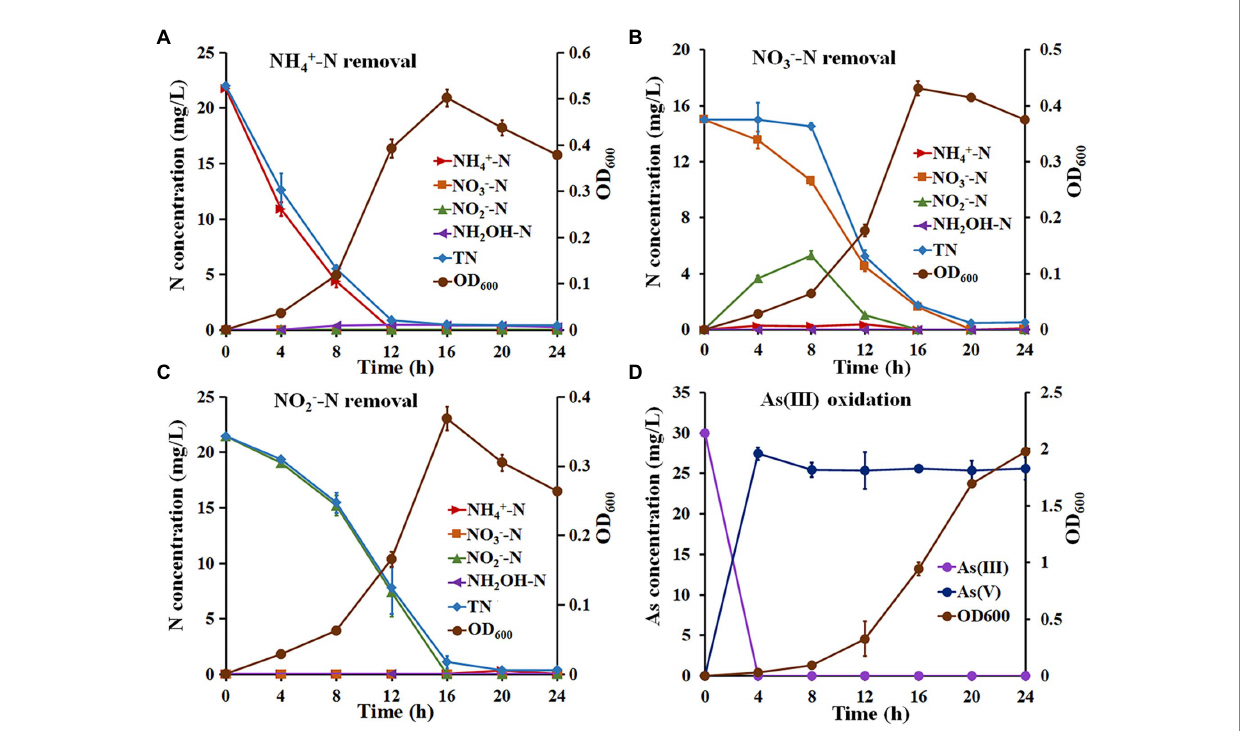
FIGURE 1 The growth, nitrogen removal, and As(III) oxidation characteristics of strain H7. The growth and nitrogen removal curves of strain H7 using NH 4+ -N (A) , NO 3 − -N (B) , and NO 2 − -N (C) as sole nitrogen sources. (D) The As(III) oxidation curves of strain H7. Error bars represent the mean ± standard deviation ( n =